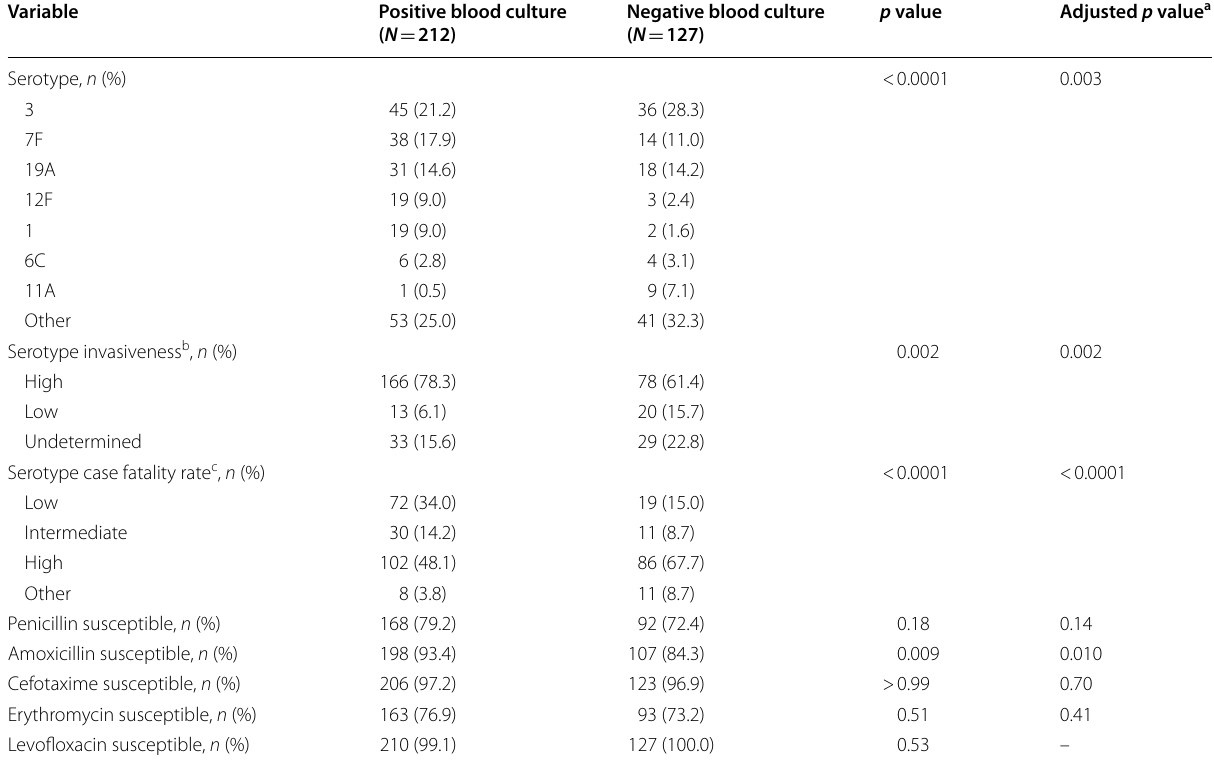
Data were available for 339 patients a Adjusted for age category, sex, BMI category, and McCabe and Charlson scores b Serotype invasiveness: high (OR > 1, p < 0.05), serotypes 1, 3, 4, 5, 7F, 12F, 14, 18C, 19A, and 9L; low (OR < 1, p < 0.05), serotypes 6A, 6C, 10A, 11A, 15A, 15C, 23B, 24F, and 37; and undetermined (OR < 1 or OR > 1 with p > 0.05), serotypes 8, 9A, 9N, 9V, 16F, 17F, 18A, 19F, 20, 22F, 23F, 29, 31, 33F, 34, 35B, and 35F c Serotype case fatality rate: low (serotypes 1, 4, 5, 7F, and 8), intermediate (serotypes 9V, 12F, 14, and 22F), or high (serotypes 3, 6A, 6B, 6C, 9N, 11A, 19A, 19F, and 23F)